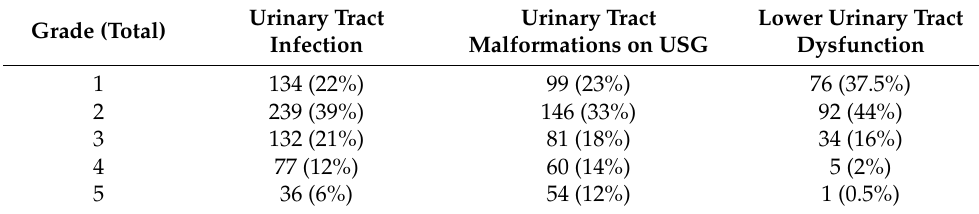
Table 2. Grading of positive reflux, depending on indication for